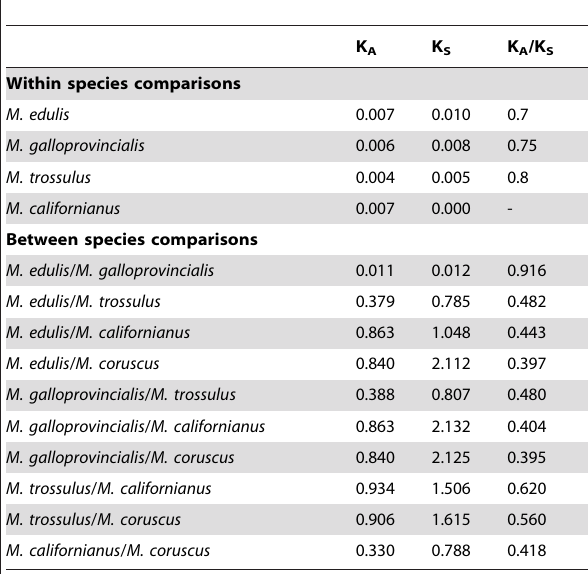
Table 5. DNA comparisons in the Mytilus F lineage for the fast evolving F- orf-vd1 gene: selective pressures at synonymous and nonsynonymous